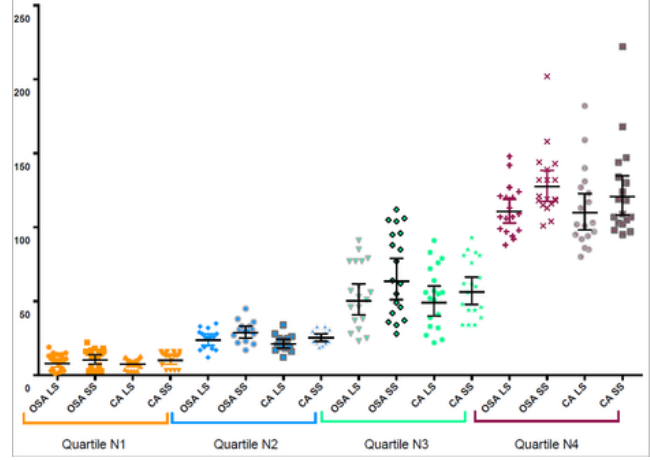
Figure 1: FVIII:C divided in quartiles. OSA: One-stage clotting assay, CA: chromogenic test, LS: local reference standard, SS: product-specific reference